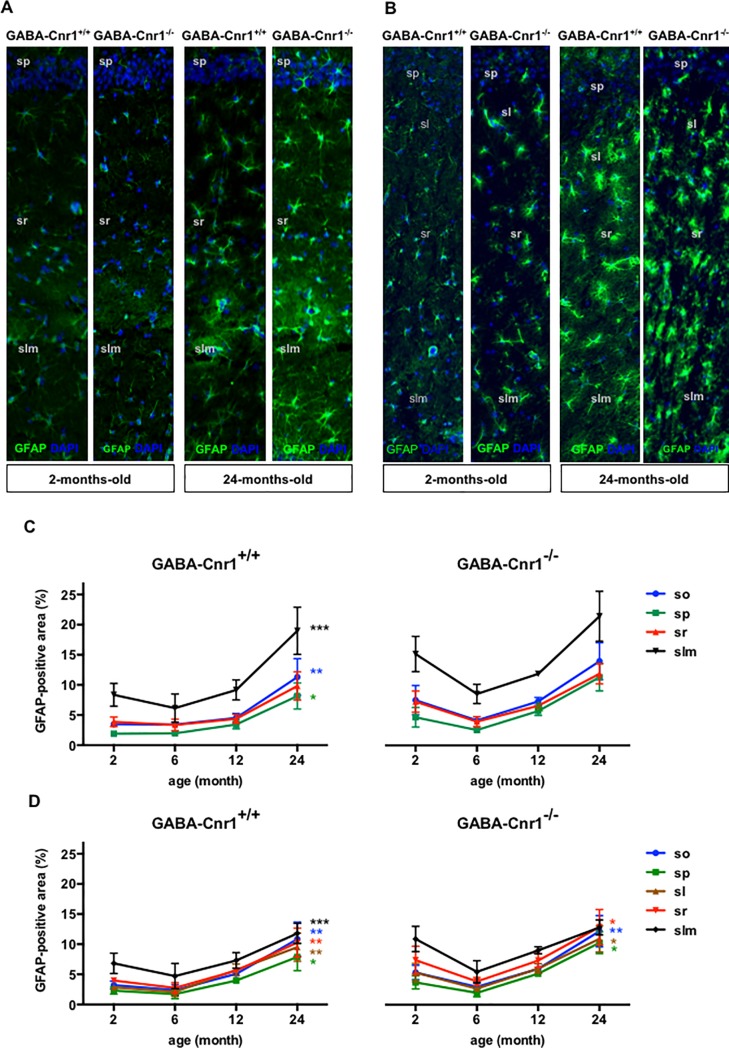
Representative photomicrographs of GFAP-immunopositive astrocytes in the hippocampal CA1 (A) and CA3 (B) layers from 2- and 24-months-old GABA-Cnr1+/+ and GABA-Cnr1−/− mice. The width of the panels is 100 μm. (sp) stratum pyramidale, (sl) stratum lucidum, (sr) stratum radiate, (slm) stratum lacunosum-moleculare. Spatial distribution of GFAP-immunopositive areas within layers of the hippocampal CA1 (C) and CA3 (D) regions in 2-, 6-, 12- and 24-month-old GABA-Cnr1-/- and GABA-Cnr1+/+ littermates, respectively * p < 0.05: ** p < 0.01; *** p < 0.001 significantly different compared to 2-months-old mice from the same genotype. Color of the asterisk refers to the layer indicated in the figure legend. n = 5–6 per age group and genotype. Symbols indicate mean values and error bars standard error of means.